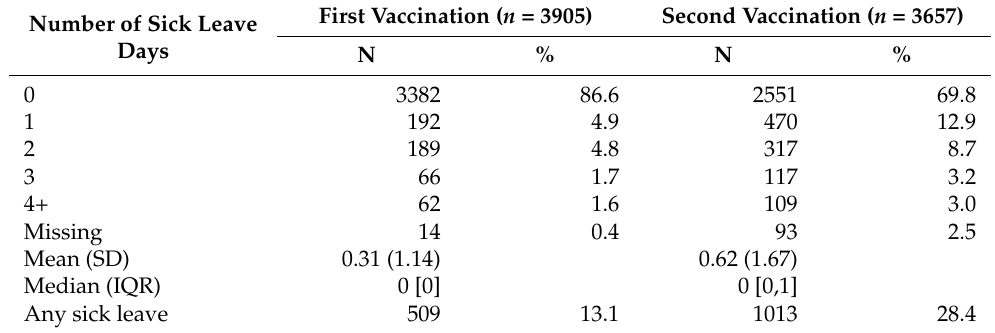
Table 5. Number and percentages of sick leave days after the first and second COVID-19 vaccination. Number of Sick Leave